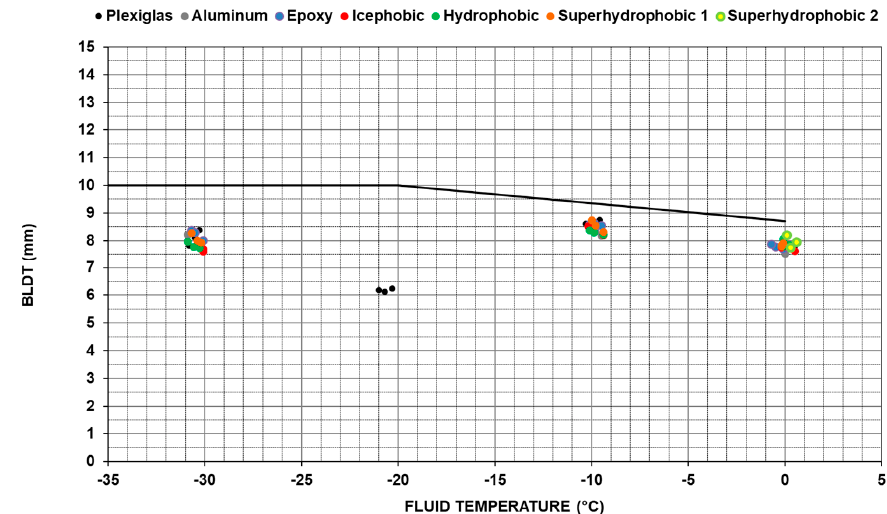
Figure 15. BLDT results for all surfaces in function of temperature for Fluid B (flat line showing the acceptance limit).